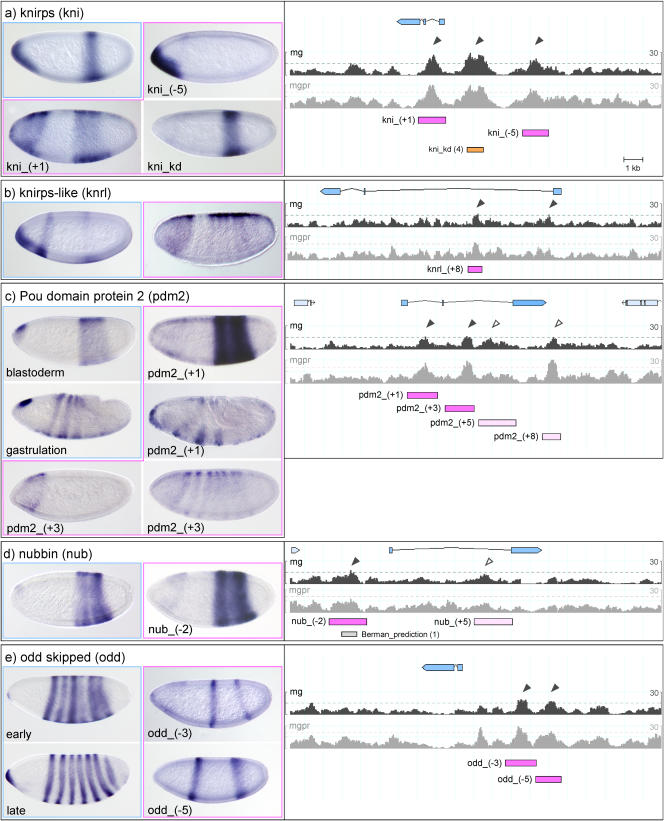
Expression Patterns Driven by Ahab-Predicted Modules IISee legend for Figure 2. (A) kni, (B) knrl, (C) pdm2, (D) nub, and (E) odd.